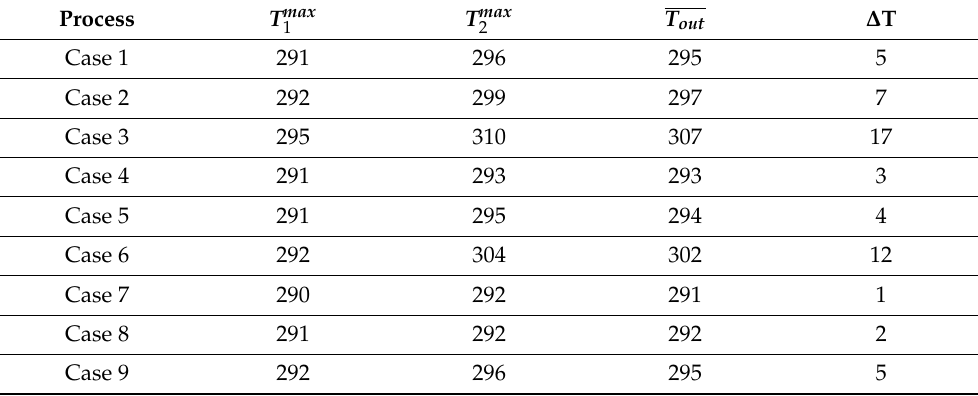
Table 3. System Internal Temperature